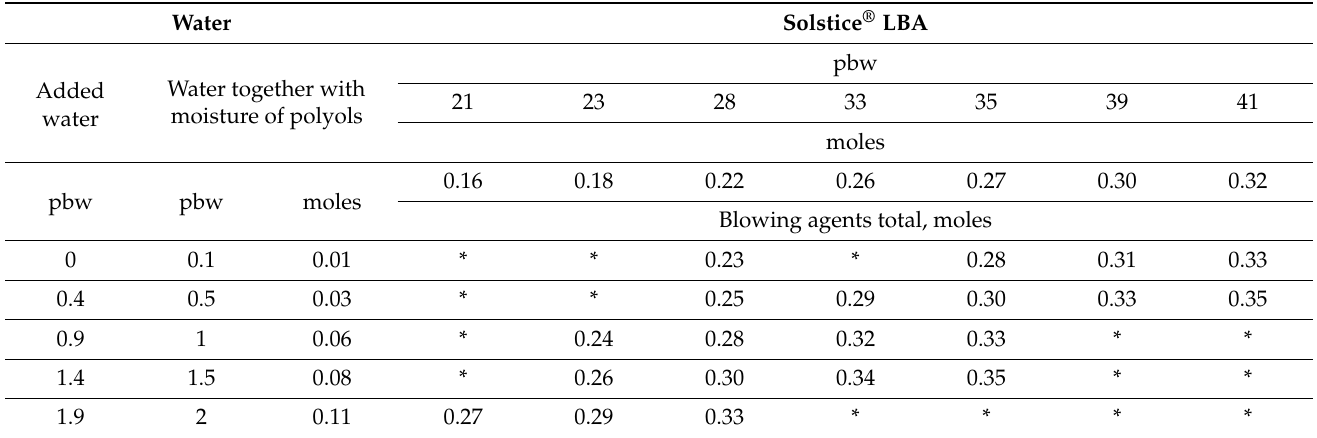
Table 3. Content of blowing agents in moles used in pouring tests.